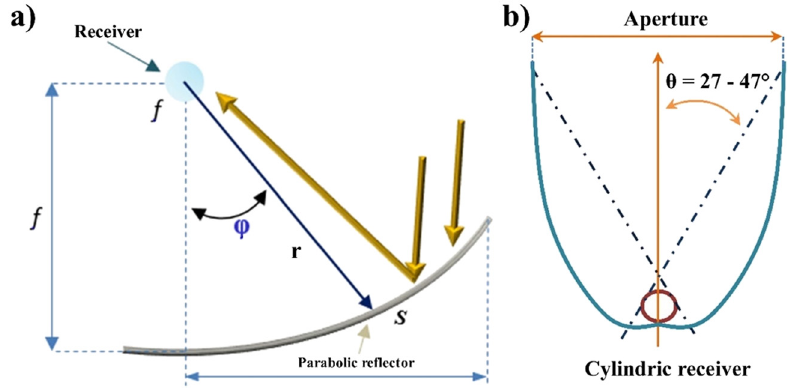
Figure 2: The parameters and proportions for ( a ) parabolic trough and ( b ) compound parabolic channel